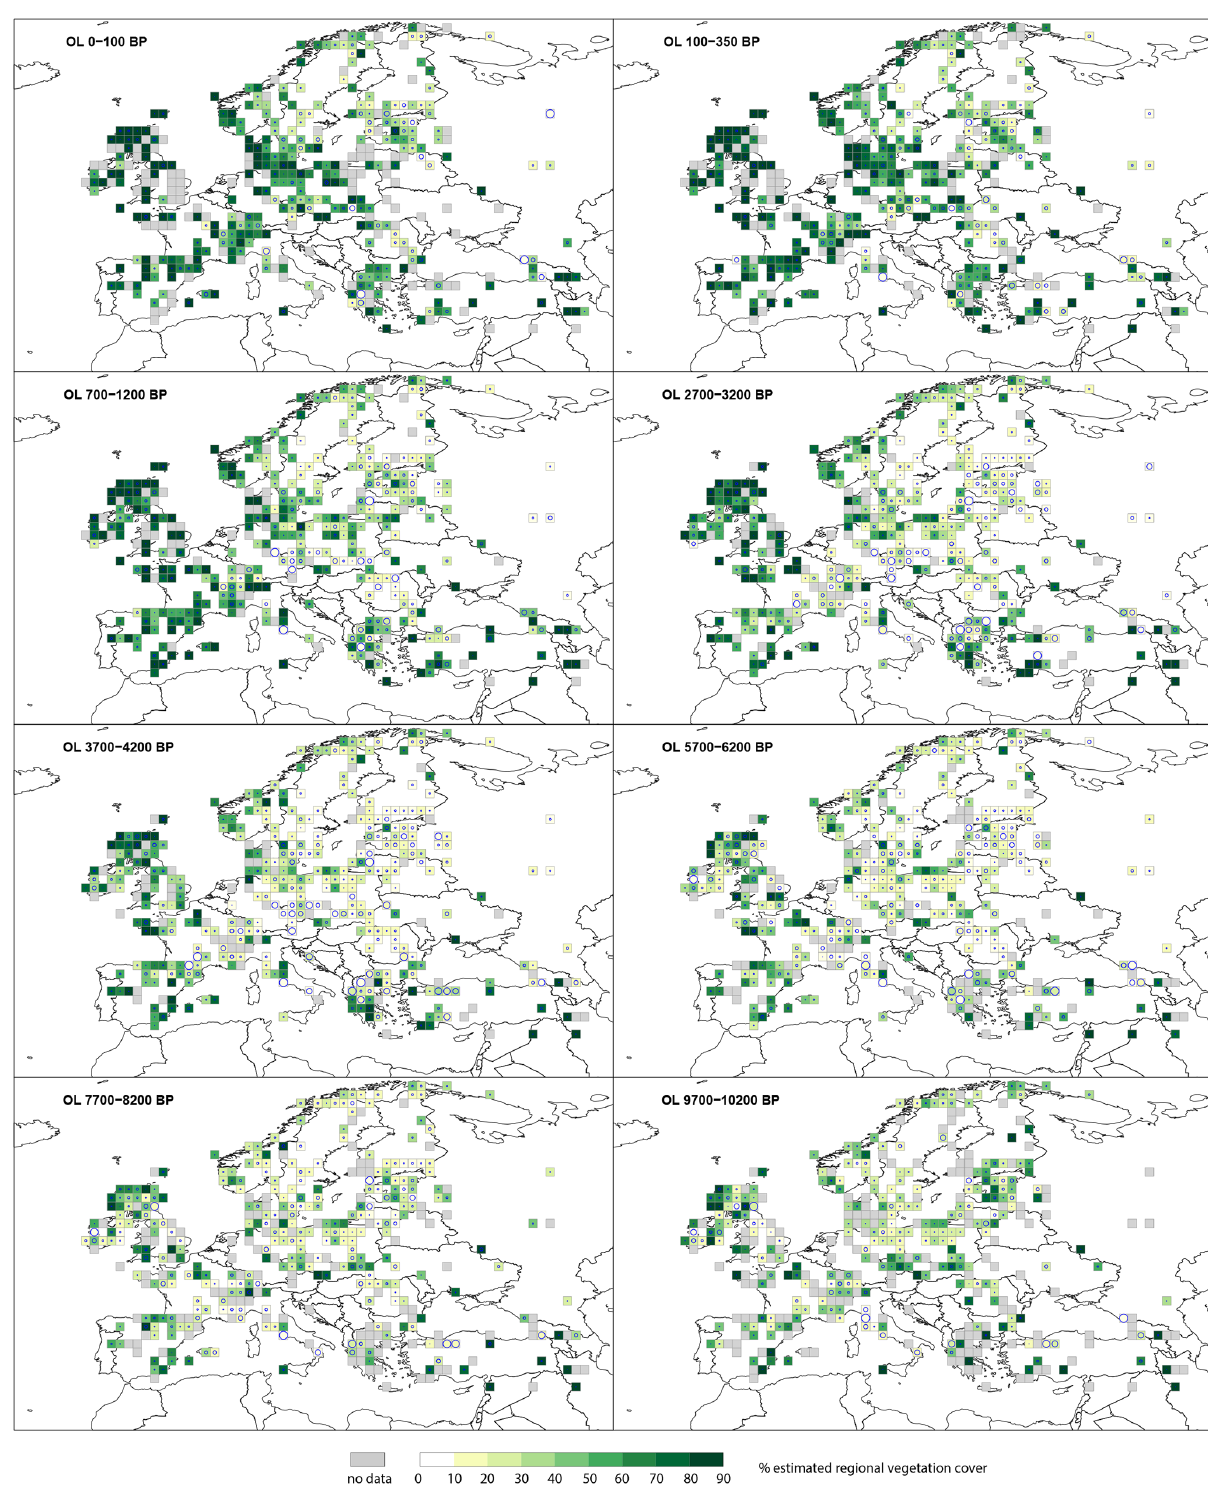
Figure 2. Grid-based REVEALS estimates of open land (OL) cover for eight Holocene time windows. Percentage cover of open land in 10% intervals represented by increasingly darker shades of green from 20%. Grey cells: cells without pollen data for the time window but with pollen data in other time windows. Circles in grid cells represent the coefficient of variation (CV; the standard error divided by the REVEALS estimate). When SE ≥ REVEALS estimate, the circle fills the entire grid cell, and the REVEALS estimate is not different from zero. This occurs mainly where REVEALS estimates are